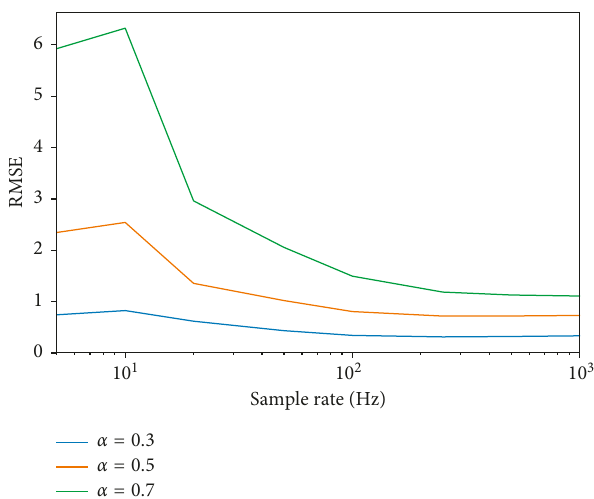
Figure 4: Root mean-squared error of different fractional derivatives with different sample